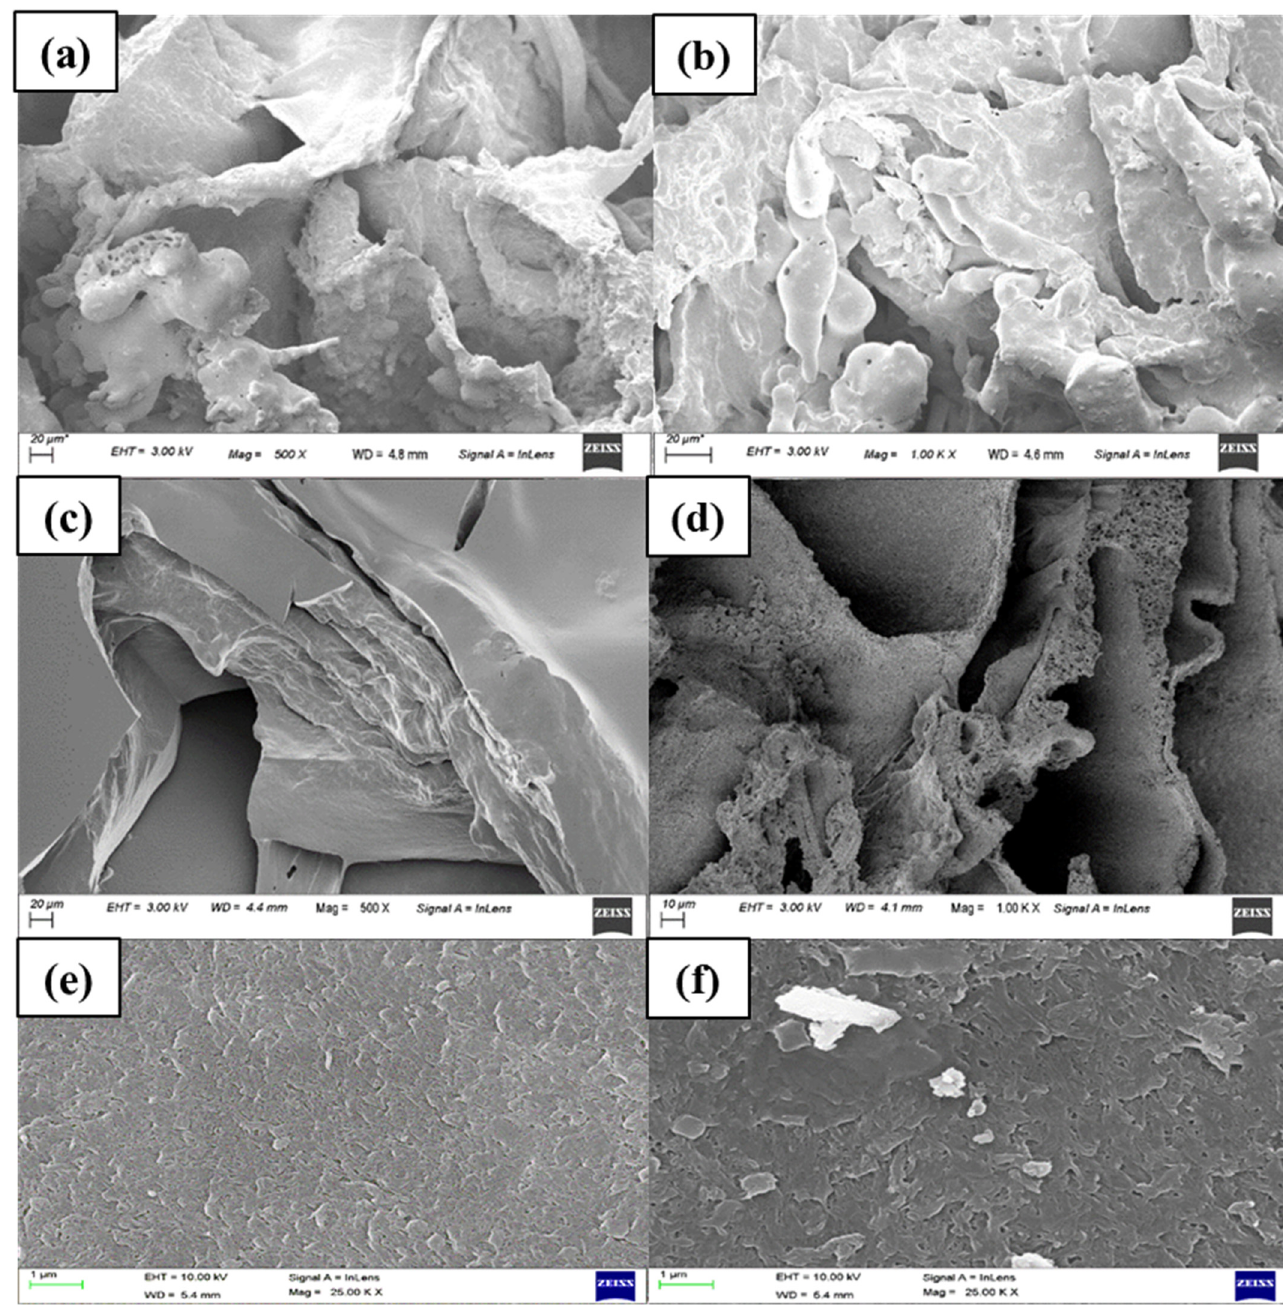
Figure 4. FESEM image of hydrogel before experiment ( a ) at 500×, ( b ) at 1000×, after experiment (12th cycle), ( c ) at 500×, ( d ) at 1000×, image of ( e ) new membrane, ( f ) used membrane.